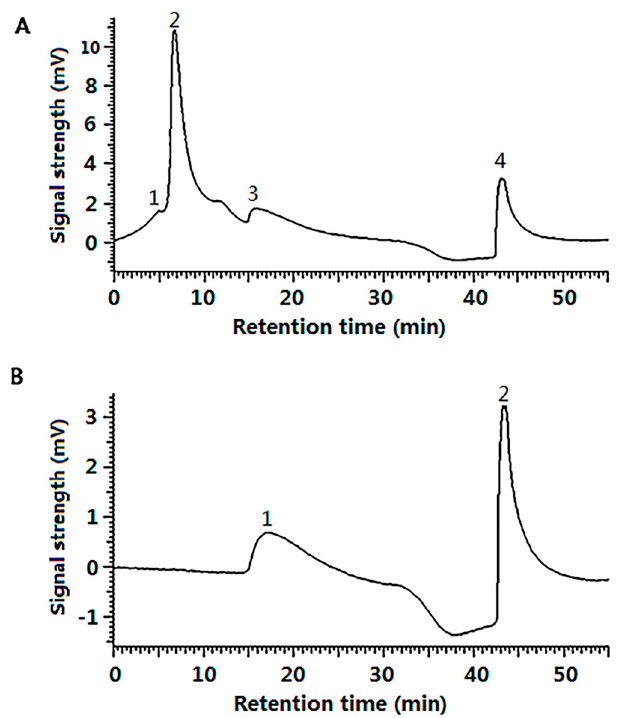
Figure 3. Gel filtration chromatography of G-SOD ( A ) and Cu/Zn SOD ( B ).